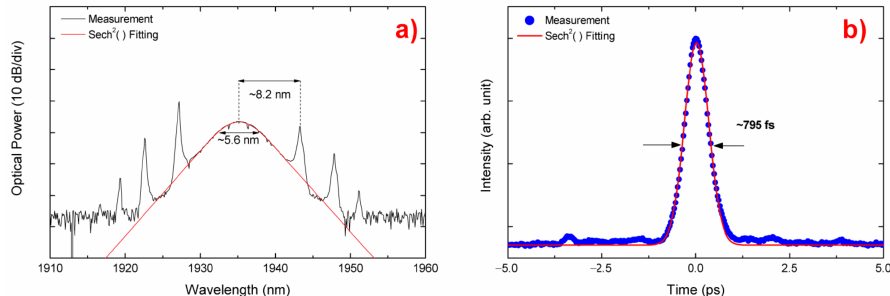
Figure 13. ( a ) Measured optical spectrum of amplified pulses. ( b ) Measured autocorrelation trace. Reprinted with permission from